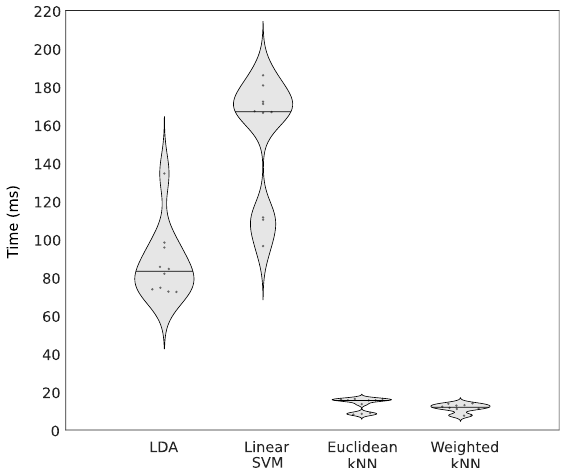
Figure 3. Execution times to predict the quality of 1 s EEG segment for each classifier. The straight line in each violin plot, represents the median value.